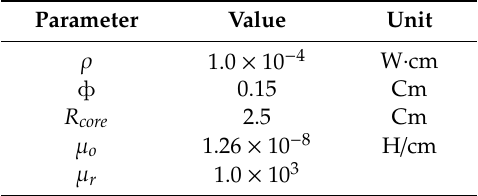
Table 4. Parameters of the shielded-CPT system for the design example.